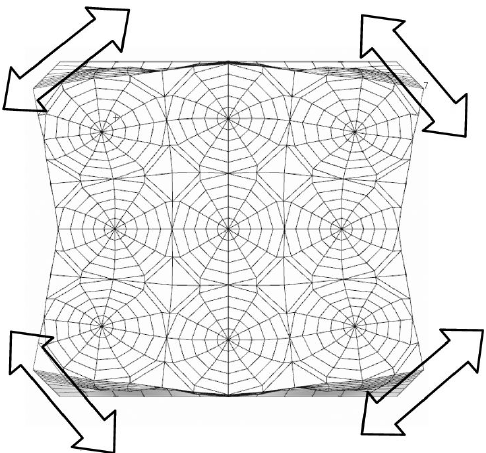
Fig. 31. 8th mode: − 1346 Hz (1587 Hz – Quad-cell).